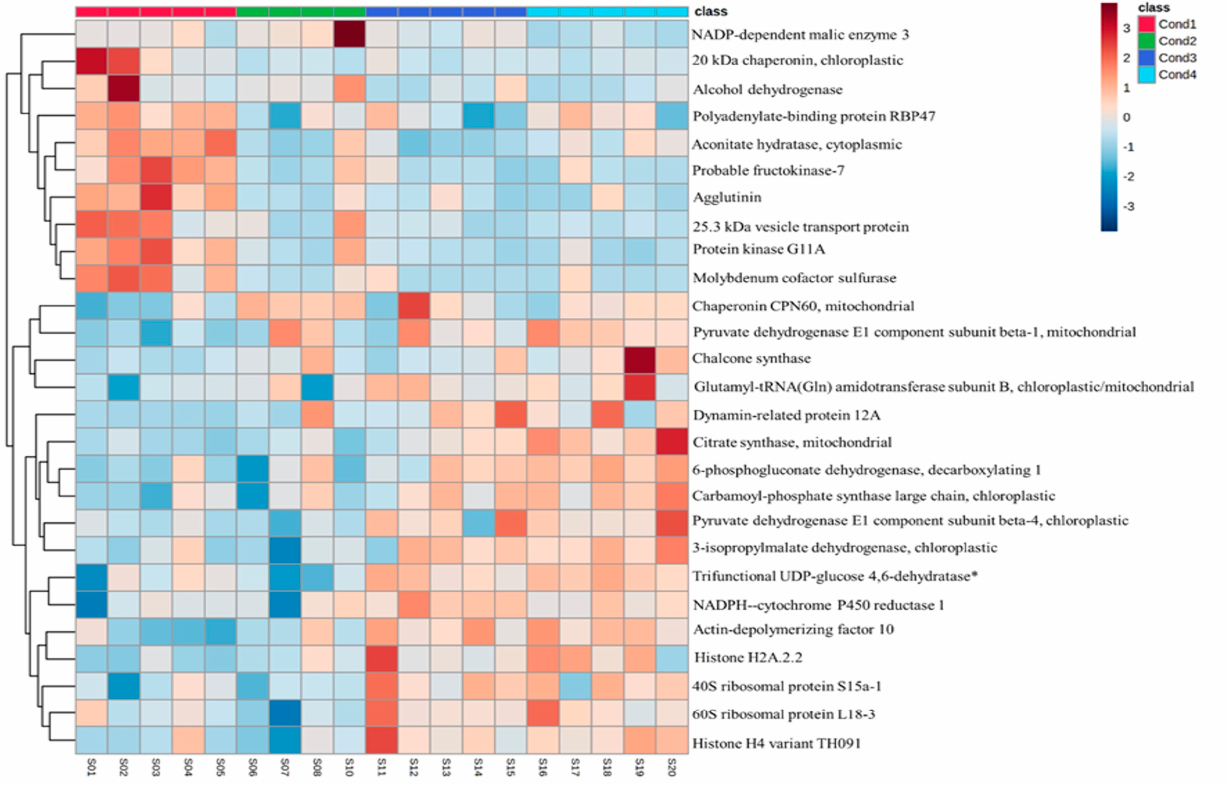
Figure 4. Hierarchical clustering heatmap using the 27 proteins selected, with the combination of univariate and multivariate analysis, from EMs induced under four different temperature treatments (Cond1: 23 ◦ C; Cond2: 40 ◦ C (4 h); Cond3: 50 ◦ C (30 min); Cond4: 60 ◦ C 5 (min)); S01–S20, sample1 to sample20. Hierarchical clustering was performed only at the protein (rows) level using Euclidean distance and complete for the clustering algorithm. * Trifunctional UDP-glucose 4.6-dehydratase/UDP-4- keto-6-deoxy-D-glucose 3.5-epimerase/UDP-4-keto-L-rhamnose-reductase RHM1. The second main group gathers the proteins with increased amounts in samples from heat stress treatments. Apart from the heat-shock protein chaperonin CPN60, which presented the highest fold change between 40 ◦ C (4 h) and the control (Table 1), pro- teins presented higher concentrations at 50 ◦ C (30 min) and 60 ◦ C (5 min). It seems important to mention that the majority of the proteins with increased amounts at samples induced at higher temperatures include enzymes directly involved in the regulation of metabolism: a high number of proteins with increased concentrations under heat stress conditions implicated glycolysis and the tricarboxylic acid cycle (pyruvate dehydrogenase E1 component subunit beta-4, citrate synthase, pyruvate dehydrogenase E1 component subunit beta-1, trifunctional UDP-glucose 4.6-dehydratase/UDP-4-keto-6-deoxy-D-glucose 3.5-epimerase/UDP-4-keto-L-rhamnose-reductase RHM1, 6-phosphogluconate dehydro- genase decarboxylating 1), a membrane-bound enzyme required for electron transfer from NADPH to cytochrome P450 (NADPH–cytochrome P450 reductase 1), as well as amino acid biosynthesis (3-isopropylmalate dehydrogenase, carbamoyl-phosphate syn- thase large chain) and flavonoids formation (chalcone synthase), were identified. Addi- tionally, proteins involved in DNA binding and cellular division (dynamin-related pro- tein 12A, actin-depolymerizing factor 10), transcription regulation (histone H4 variant TH091, histone H2A.2.2) and the life-cycle of proteins, such as those directly related with nuclear (40S ribosomal protein S15a-1, 60S ribosomal protein L18-3) and mitochondrial (glutamyl-tRNA (Gln) amidotransferase subunit B) translation, were present in this group. NADP-dependent malic enzyme 3 and alcohol dehydrogenase presented significantly lower amounts at 60 ◦ C (5 min) compared to 40 ◦ C (4